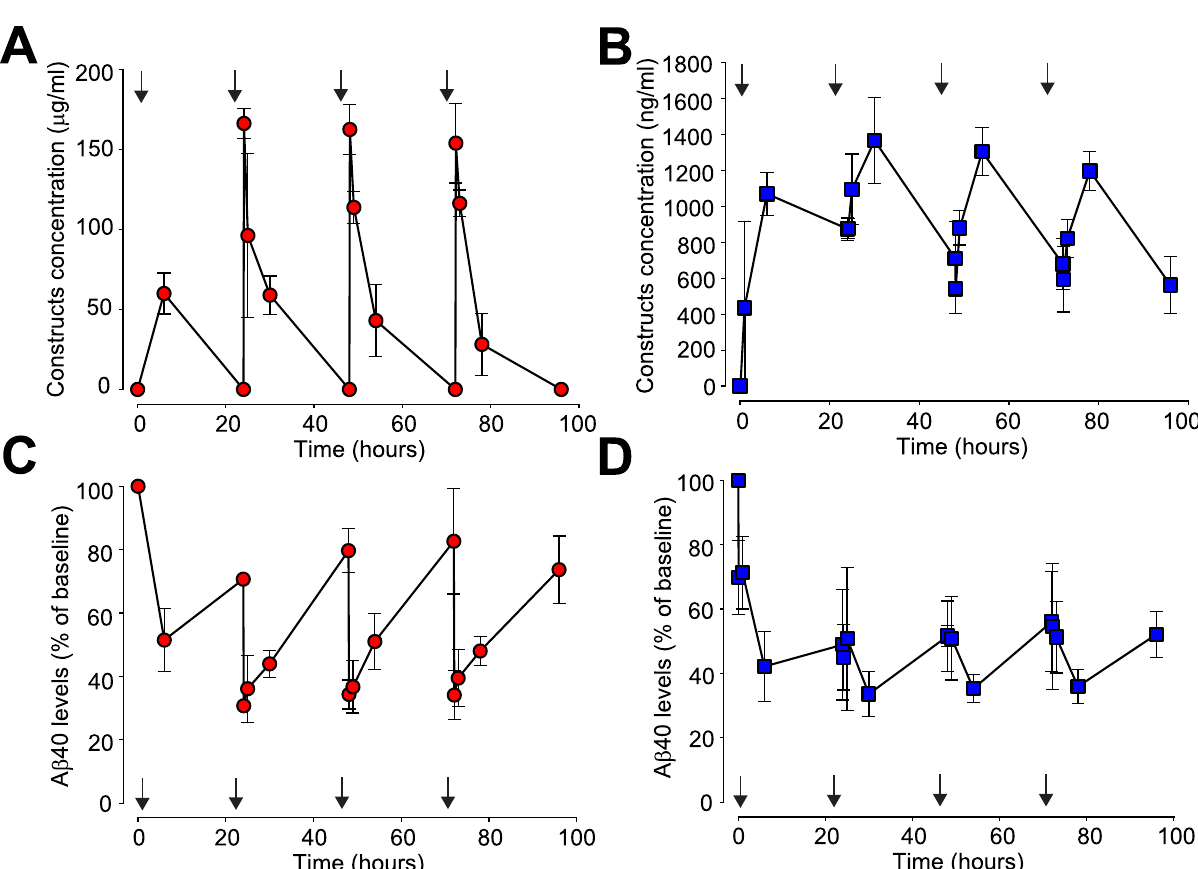
Fig 4. Prolonged A β 40 reduction in plasma and CSF after repeated dosing. (A and B) Pharmacokinetic parameters observed in (A) blood (red circles) and (B) CSF (blue squares) after repeated 10mg/kg i.v. injections (arrows) of sFab OX26-NEP in cisterna magna cannulated rats (N = 3). (C and D) A β 40 levels measured in (C) blood plasma (red circles) and (D) CSF (blue